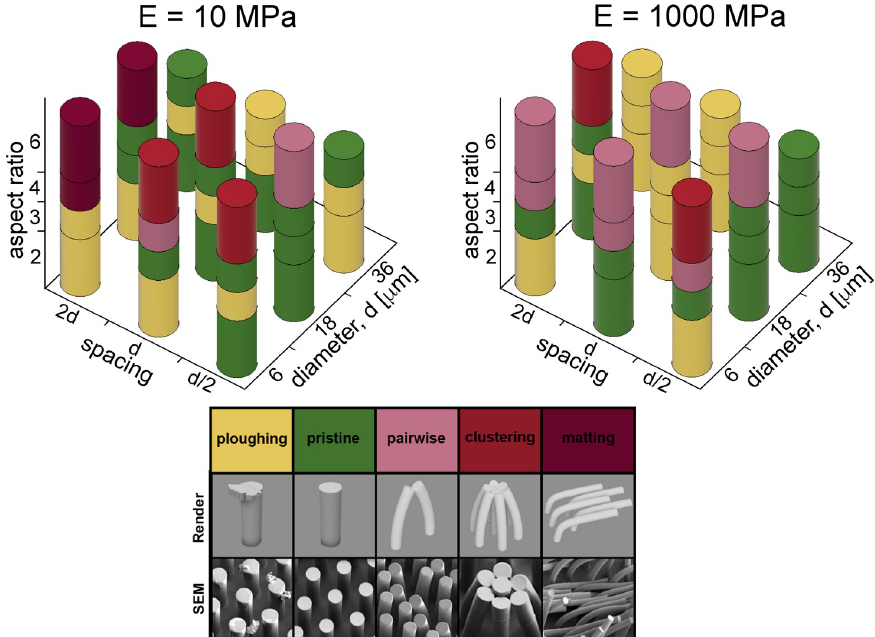
Fig 7. Resulting mechanical outcomes for all samples tested. Mechanical outcomes for all E = 10 MPa micropillar samples are shown on the left while all E = 1000 MPa micropillar results are shown on the right. The legend in the foreground assigns reds of increasing saturation for increasingly severe adhesion/deformation. Green indicates the tested micropillars remained in pristine condition while yellow was chosen for ploughing because micropillars survived despite injurious results for the replica